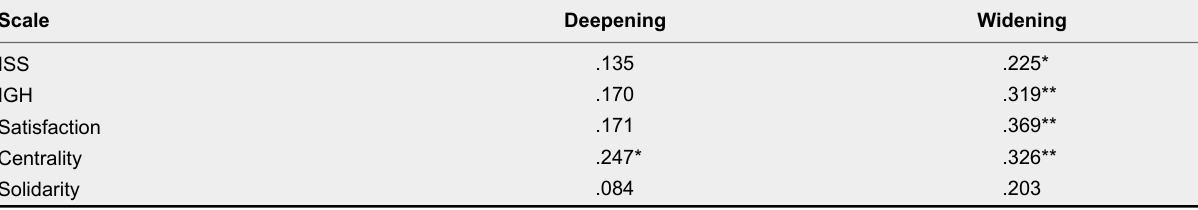
Intercorrelations Between Identification and Attitudes Towards EU Deepening and Widening